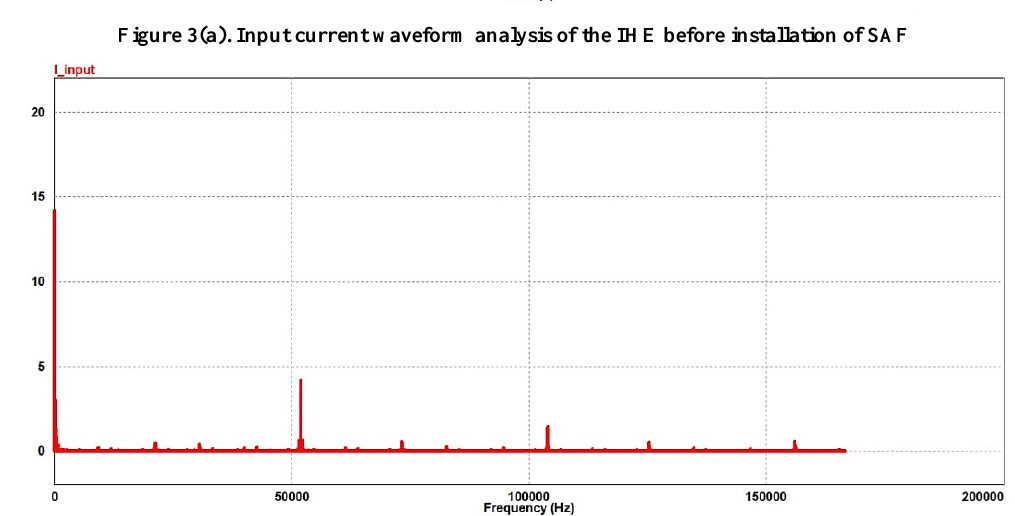
Figure 3(b). Input current FFT analysis of IHE before installation of